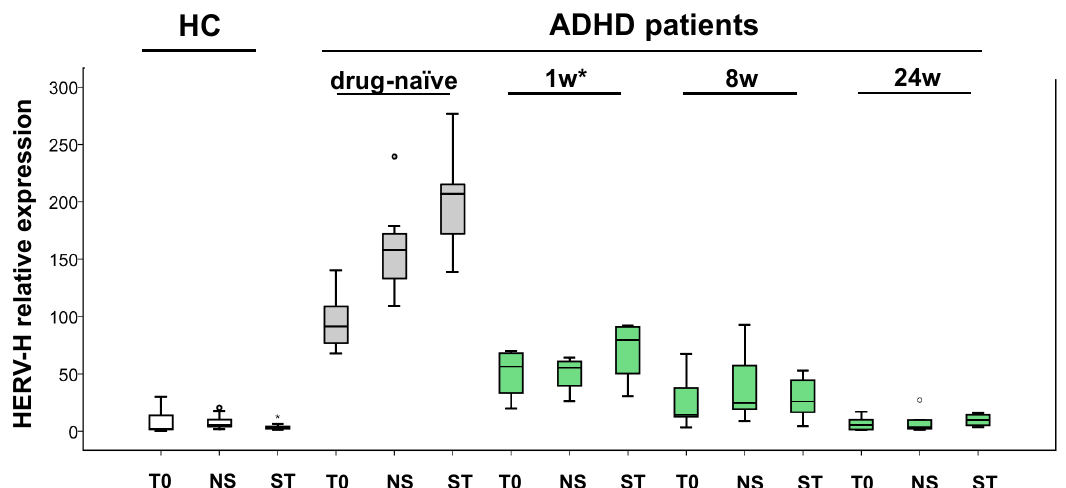
Figure 3. HERV-H expression in PBMCs from ADHD patients after in vitro culture. The relative expression of HERV-H was evaluated in fresh PBMCs (T0) and after 72 h in culture in absence (not stimulated, NS) or in presence of IL-2 and PHA (stimulated, ST). The levels were measured in seven drug-naïve ADHD patients (grey box plots) and during MPH therapy (green box plots) at 1, 8, and 24 weeks. The results were compared to those obtained in PBMCs from 12 healthy controls (HC) (white box plots), maintained in the same culture conditions (* weeks of therapy).